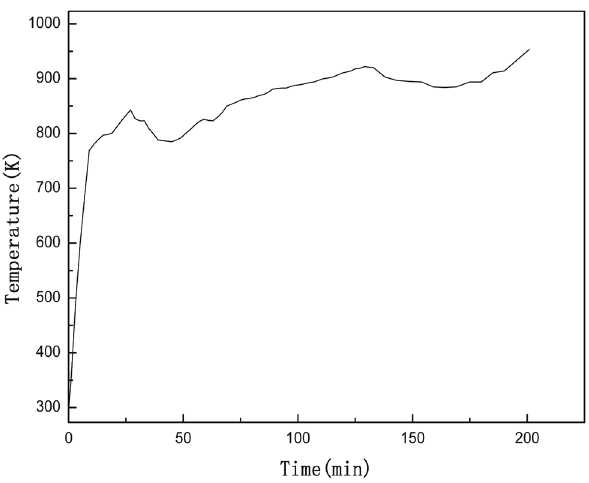
Fig. 4: Heating curve of microwave roasting of high titanium